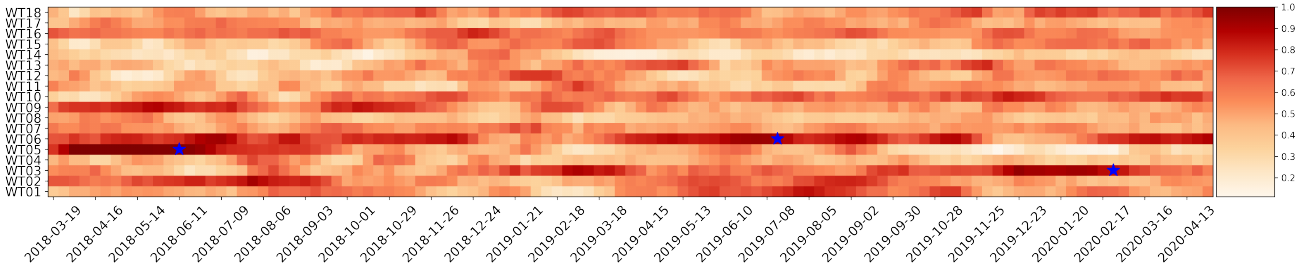
Figure 5. Main bearing health according to the proposed ensemble method. Faults are marked with a blue star.